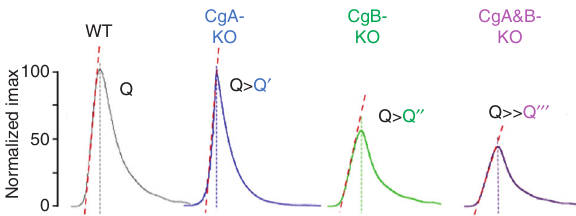
Figure 2 Kinetic profiles of amperometric spikes from Cg-KO chro- maffin